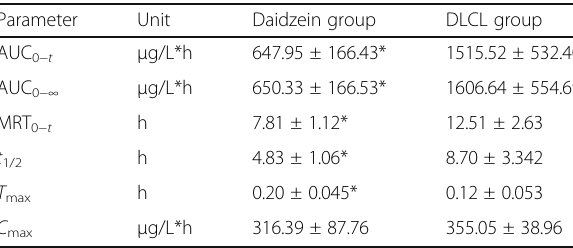
Table 5 Main pharmacokinetic parameters of daidzein after rats were orally administered with DLCL and daidzein (mean ± SD,